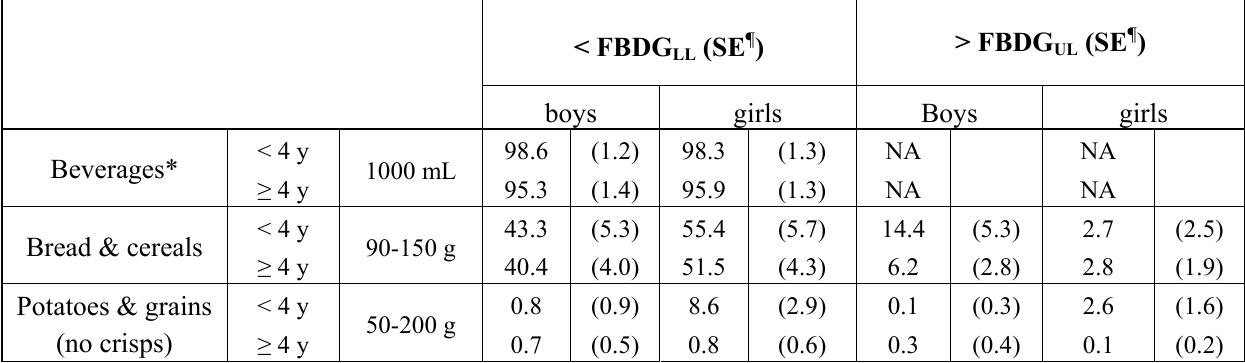
Table 2. Percentage of children below the lower limit and above the upper limit of the specific food-based dietary